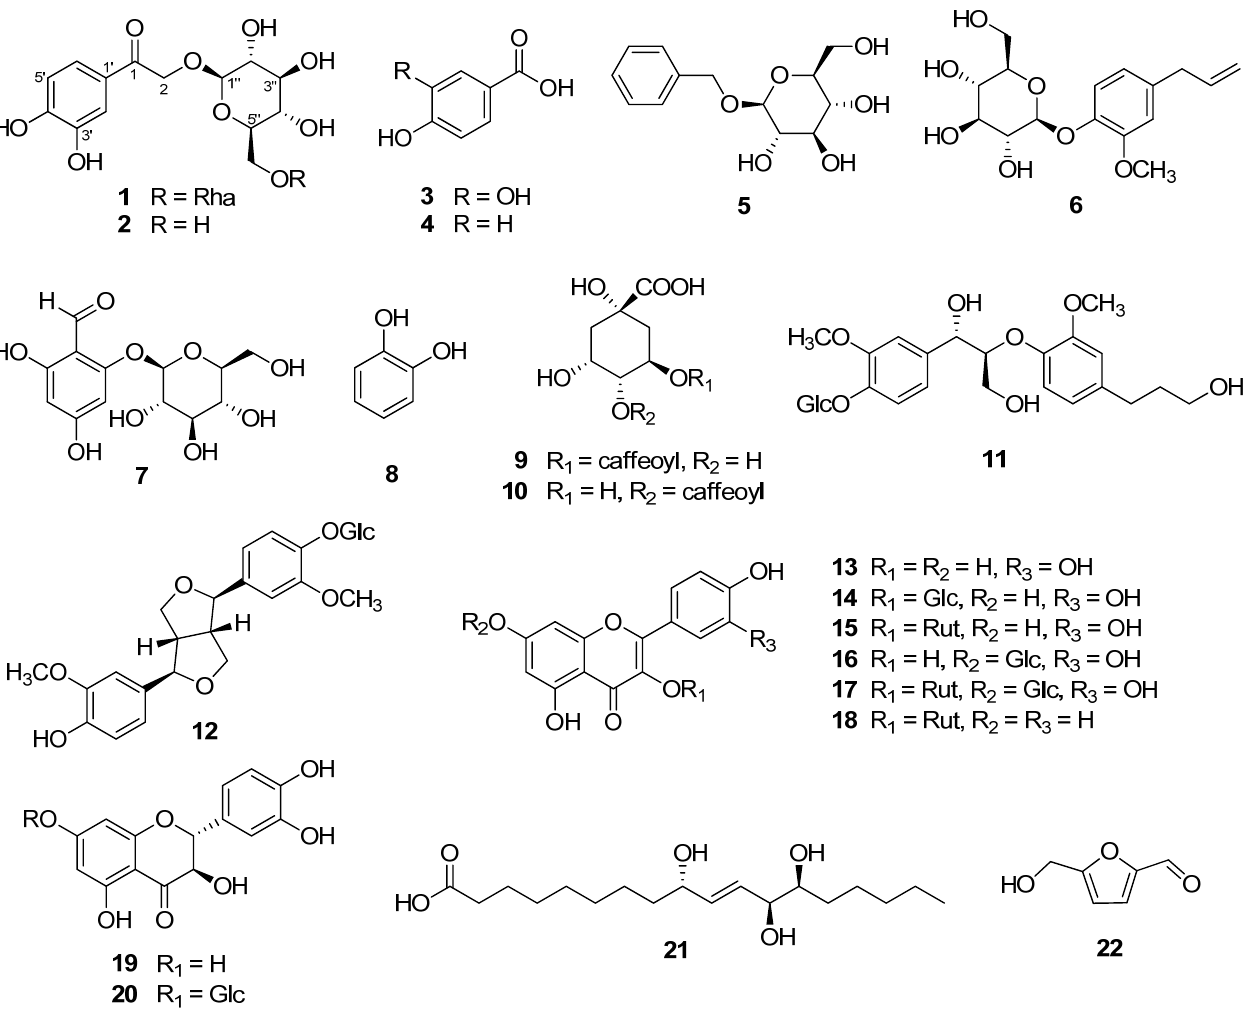
Figure 2. Structures of compounds 1 – 22 isolated from the fruits of M. alba